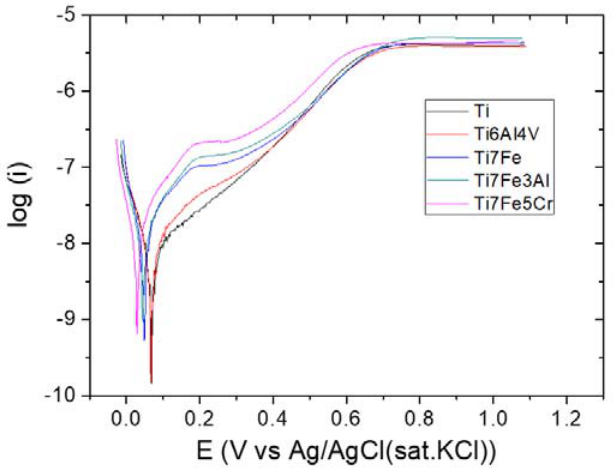
Figure 16. Potentiodynamic polarization curves of unalloyed Ti and Ti alloys .